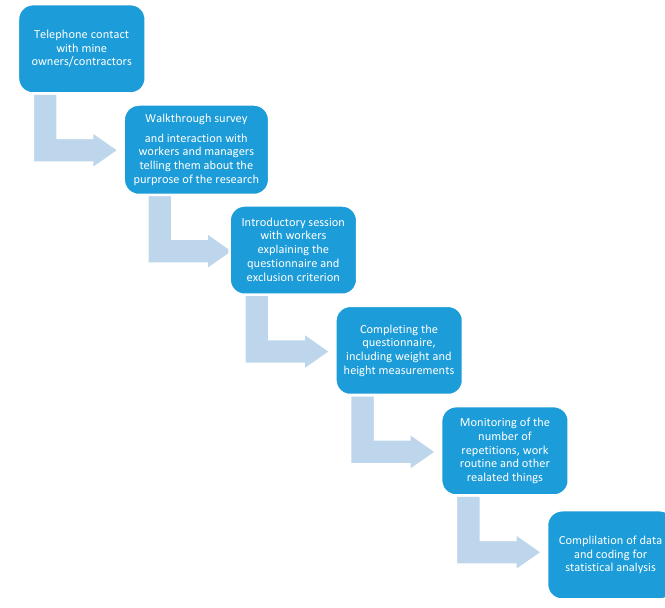
Figure 1. Process Flow Chart.